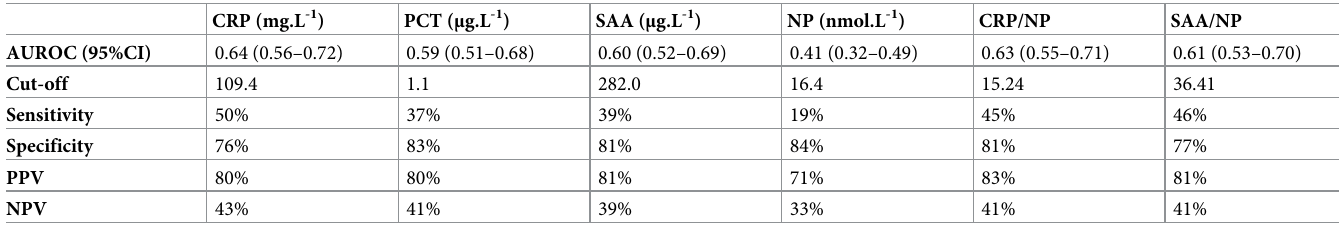
Abbreviations: AUROC (Area Under the Receiver Operating Curve), CRP for C-reactive protein, PCT for procalcitonin, SAA for serum amyloid A, NP for neopterin, PPV for positive predictive values, NPV for negative predictive